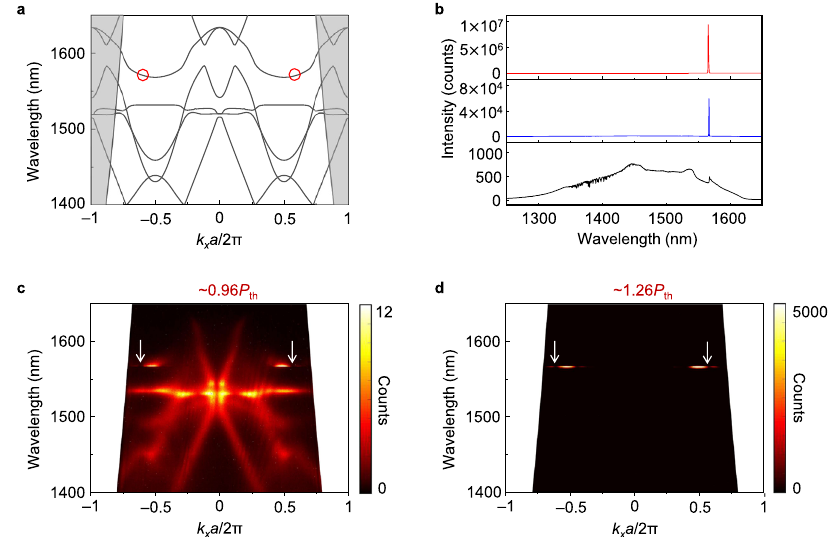
Fig. 2 | Topological polarization singular lasing with paired radiation channel. a Band diagram of the topologicalpolarizationsingularlasing along Γ - k x direction. The positions of two polarization singularities are highlighted by red circles in the second Brillouin zone. b Spontaneous emission and lasing emission of the device, which are pumped at ~0.96 P th (black), ~1.26 P th (blue), and ~5.70 P th (red) respec- tively. P th : lasing threshold. c Angle-resolved spontaneous spectra at ~0.96 P th . The